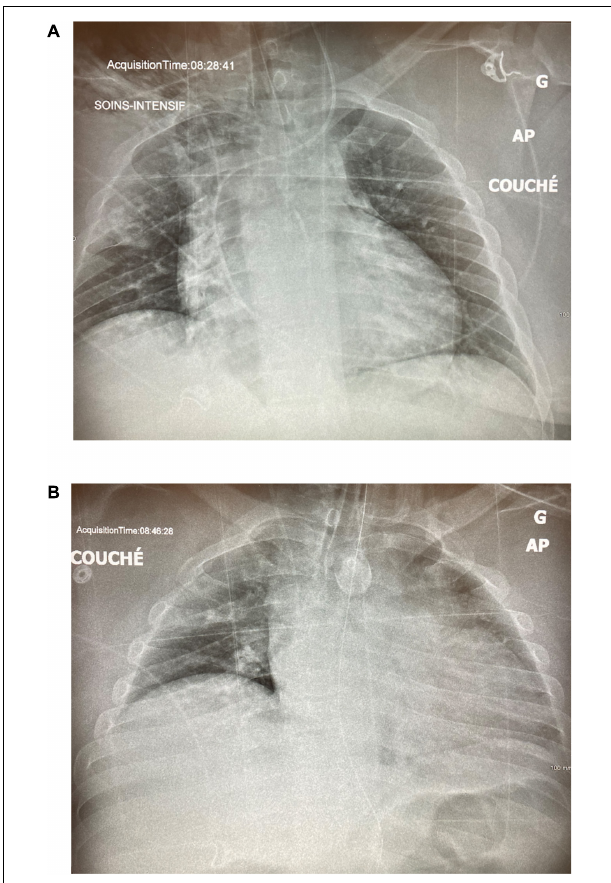
FIGURE 6 | Case 2: (A) ICU Day 5. (B) ICU Day 13.